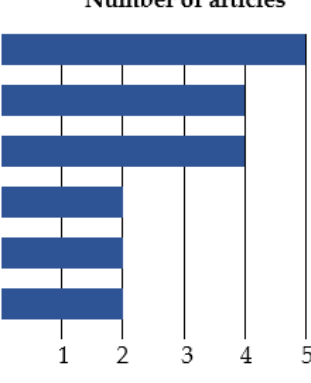
Figure 2. Journals that published at least two articles on dental caries and salivary oxidative